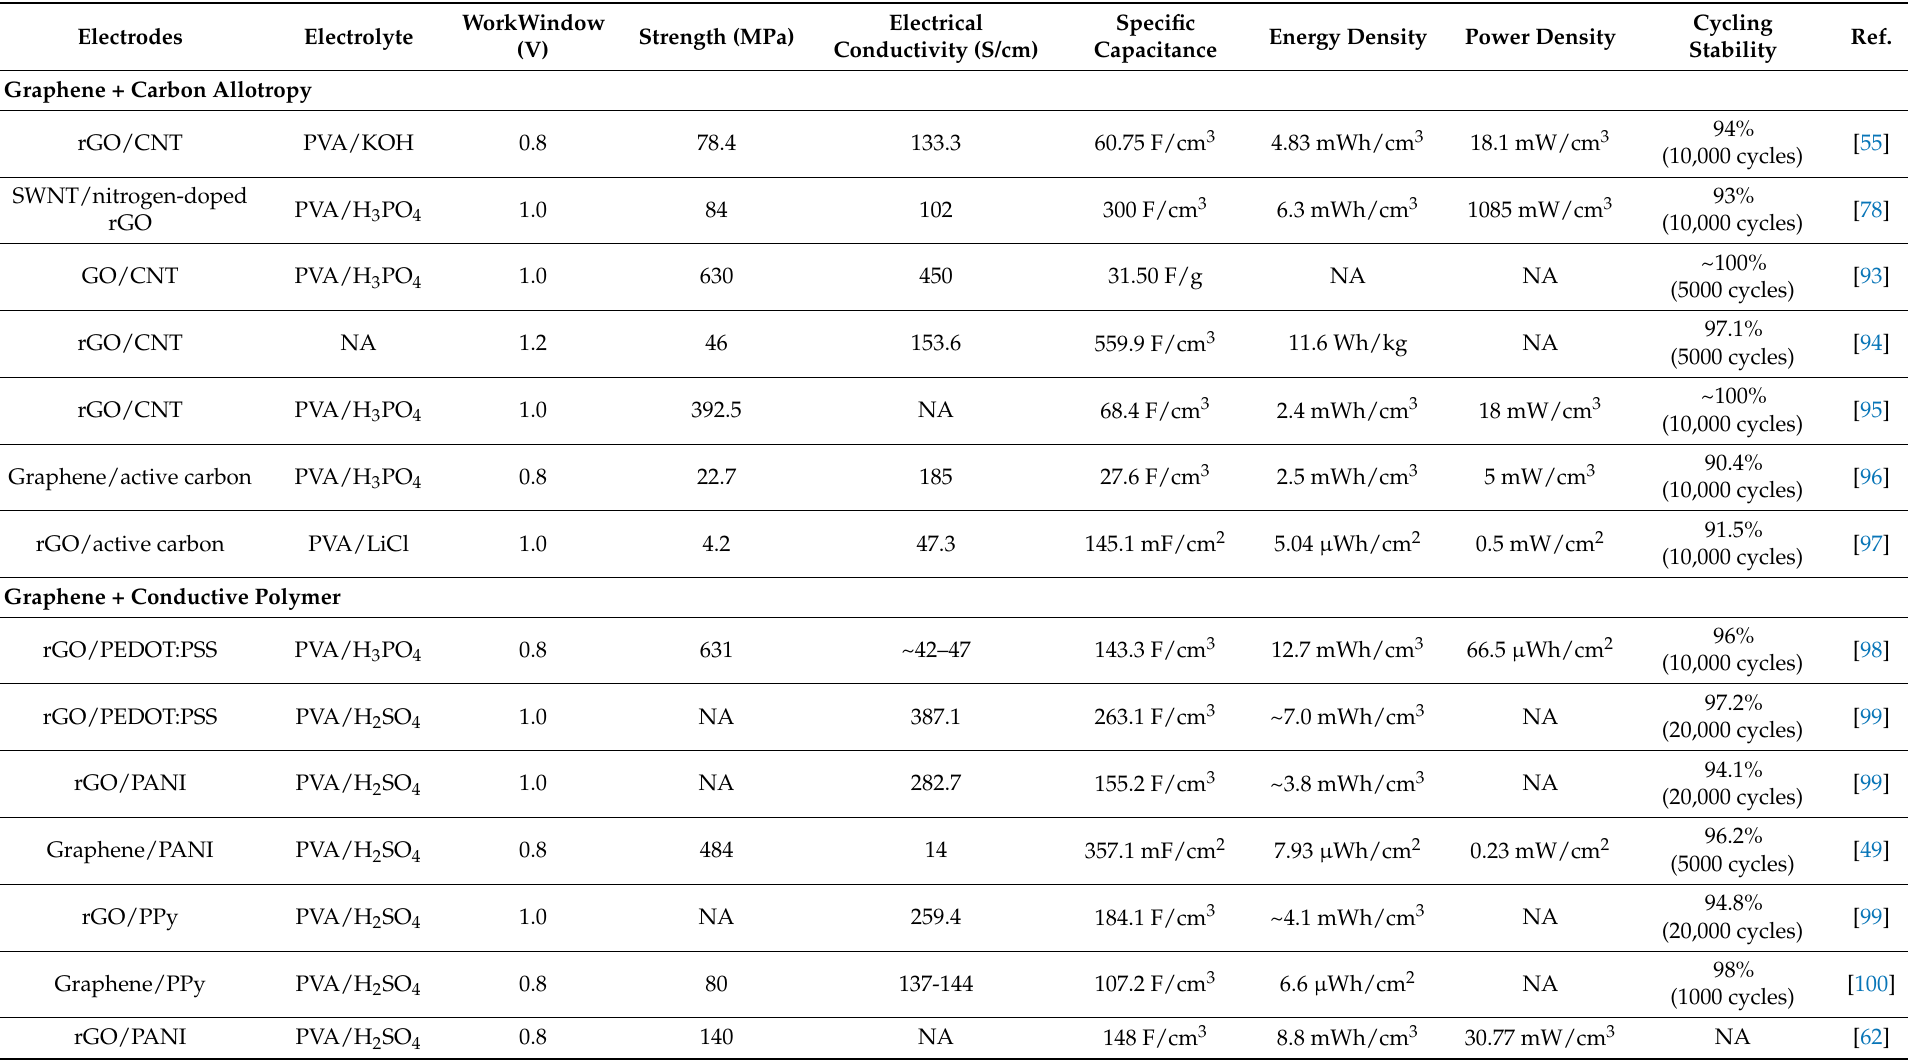
Table 2. Brief summary of the mechanical and electrochemical performance of graphene-based composite